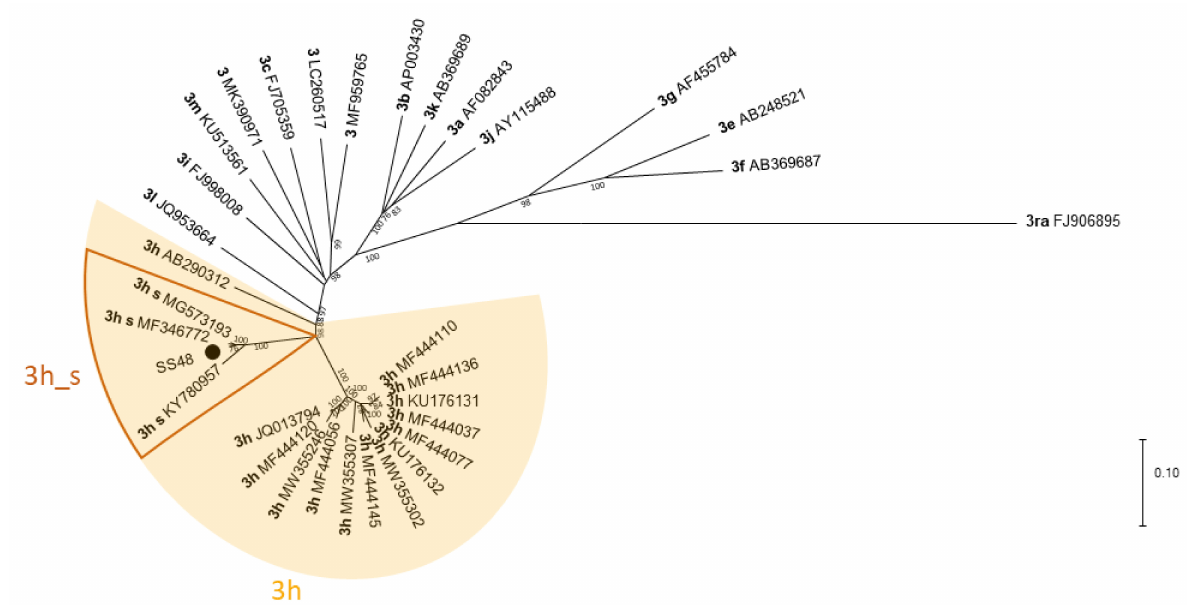
Figure 4. Phylogenetic tree based on HEV (almost) full-length sequences. The tree was constructed with MEGA X using the Maximum Likelihood method and General Time Reversible model with 1000 bootstraps. Bootstrap values ≥ 75 are indicated. The analysis involved 33 sequences, including 32 reference sequences received from the NCBI GenBank. Reference sequences are labelled with their subtype according to Smith et al. [30] and Nicot et al. [26] in bold and with their accession number. Reference sequences from Swiss strains within subtype 3h are labelled with “3h_s”. ( • ) HEV strain sequenced in this study (accession number